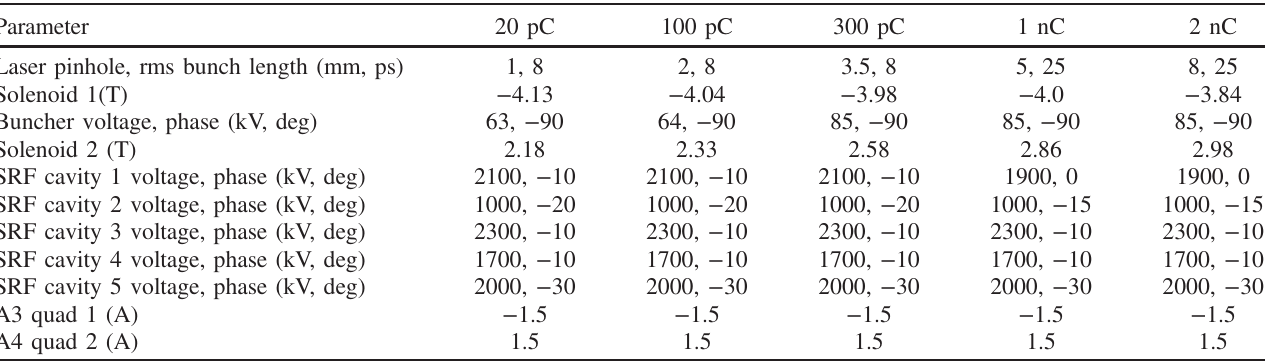
TABLE II. Injector settings.